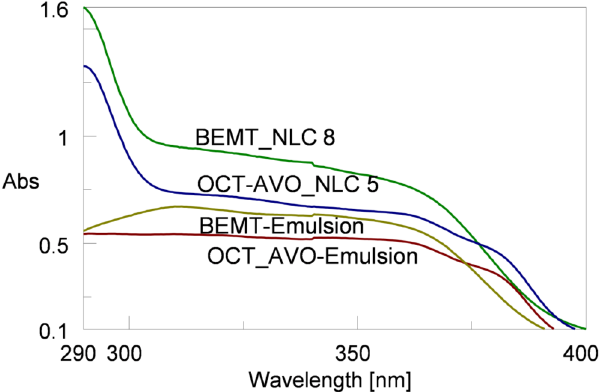
Figure 10. UV absorbance of BEMT – NLCs dispersions and BEMT – NE 10 in comparison with OCT_AVO – NLCs dispersions and BEMT – NE